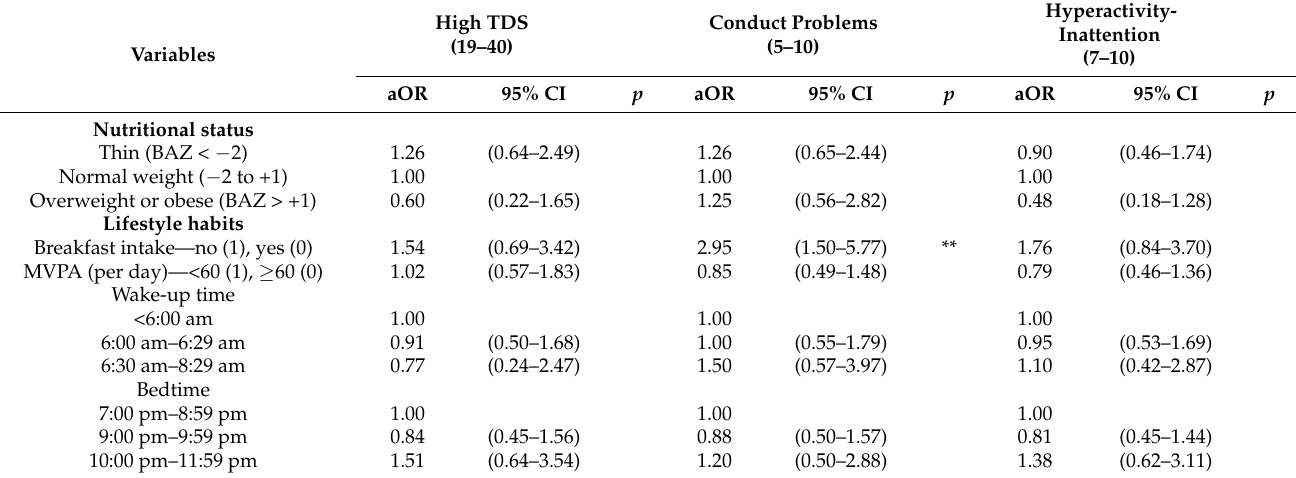
Table 2. Associations of emotional and behavioral problems with nutritional status and lifestyle habits among schoolchildren in Sri Lanka ( n =